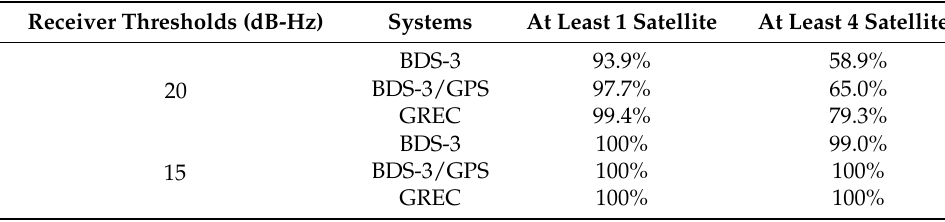
Table 8. Satellite visibility of different system combinations.